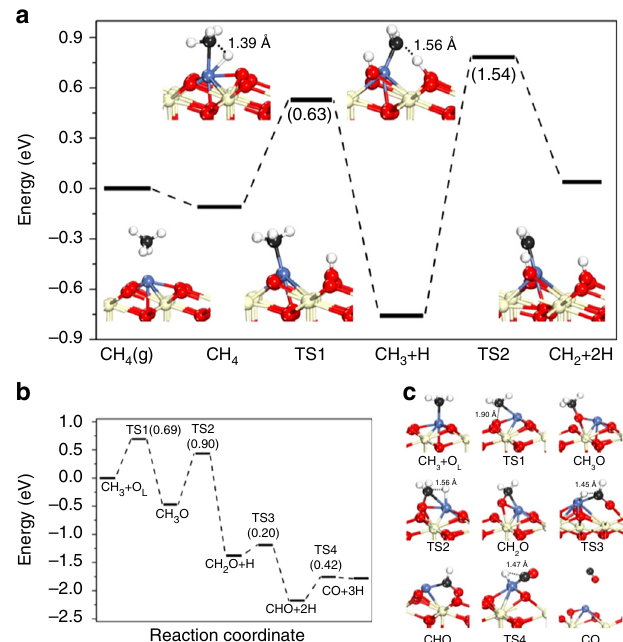
Fig. 6 DFT calculation of CH 4 decomposition. a Potential energy diagram from DFT calculations of CH 4 dissociation over Ni 1 /CeO 2 . b Potential energy diagram from DFT calculations of CH 3 oxidation and CH 3 O dehydrogenation, and c corresponding geometries over Ni 1 /CeO 2 . Numbers in parentheses indicate the activation barriers for elementary steps in